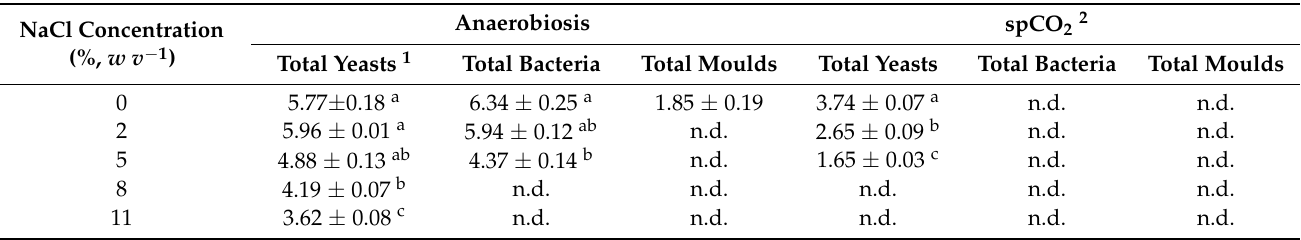
Table 2. Microbial growth in the brine of naturally processed Leccino table olives with different NaCl concentrations after one month of incubation in anaerobiosis and slightly pressurized CO 2